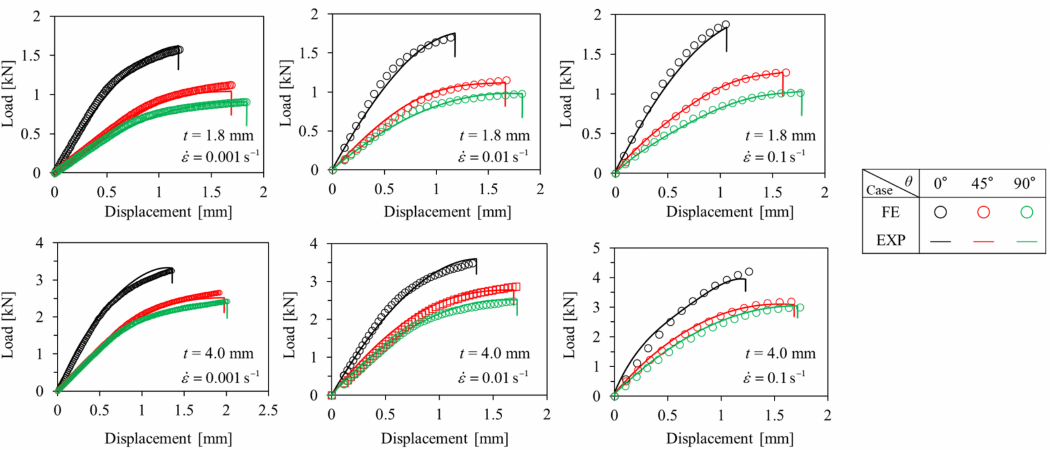
Figure 17. Comparison between experimental and numerical results for ASTM-D638 tensile